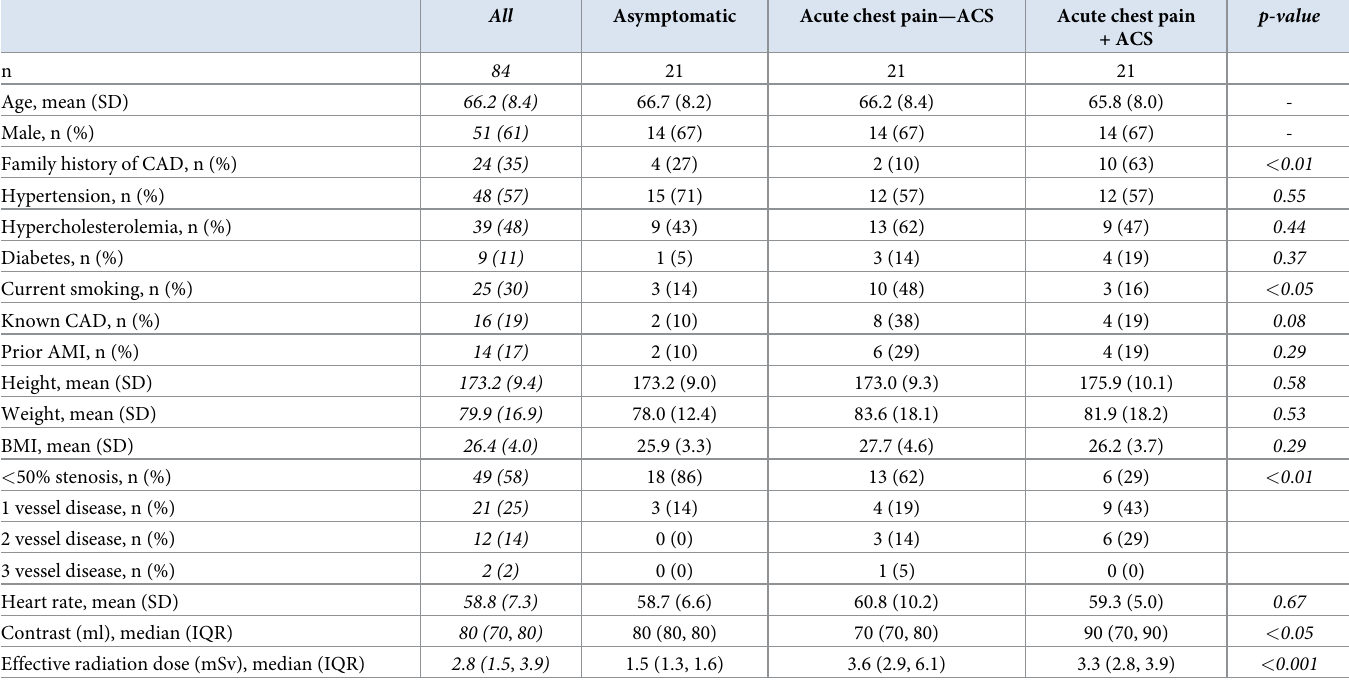
Table 2. Baseline